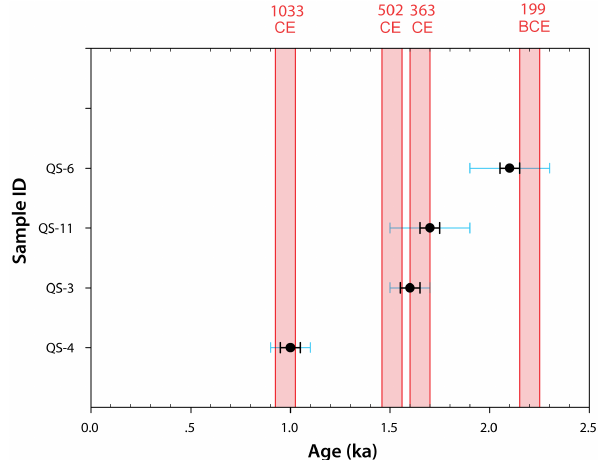
Figure 11. Clustering of rockfall events using binomial nonrandom temporal distribution using a ± 50-year time window. Dated OSL rockfall ages marked in black circles by their central OSL ages with ± 50-year black error bars and their lab-reported error ranges as light-blue bars. Historical earthquake dates are marked on the top axis and plotted with a ± 50-year time window (red stripes bounded by red solid lines represent time windows). See text for details about binomial distribution results and